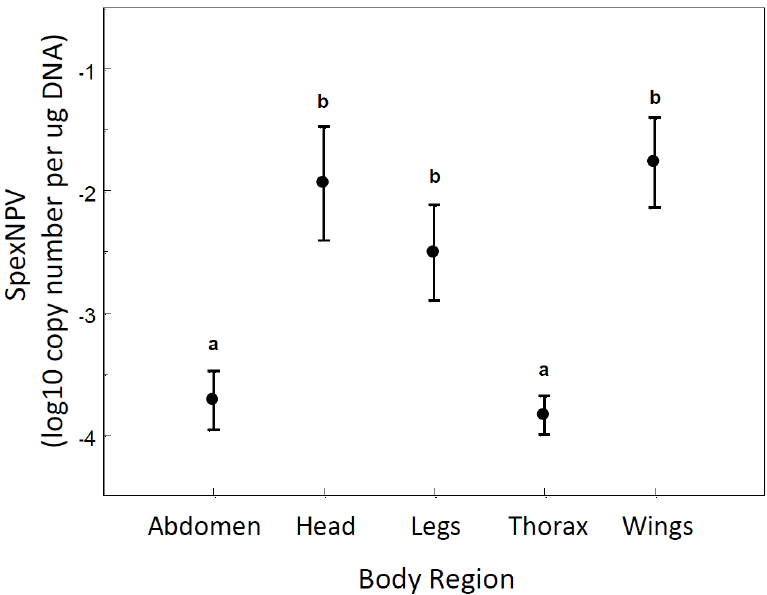
Figure 2. Covert SpexNPV DNA levels in different body regions of adult S. exempta moths. Means ± S.E. are shown. Different letters above the error bars indicate means that are significantly different according to Fisher’s least significant difference